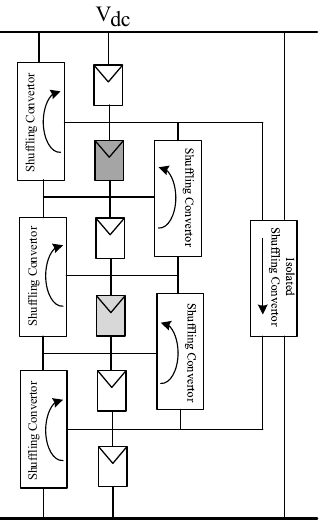
Figure 18. PV string with shuffling equalization scheme.